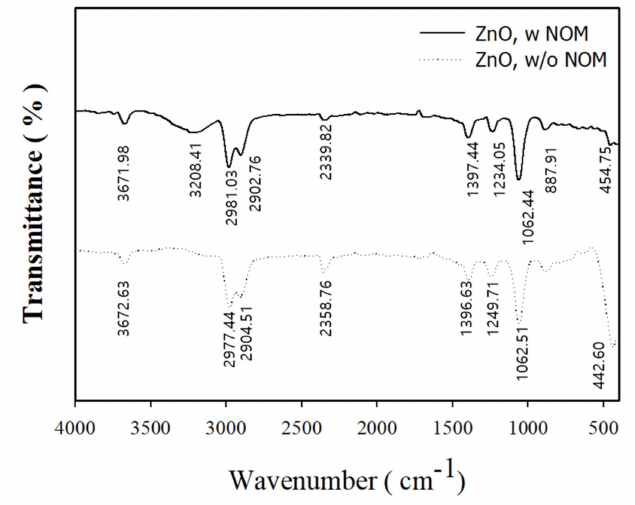
Figure 4. Fourier-transform infrared spectra of ZnO NPs with / without